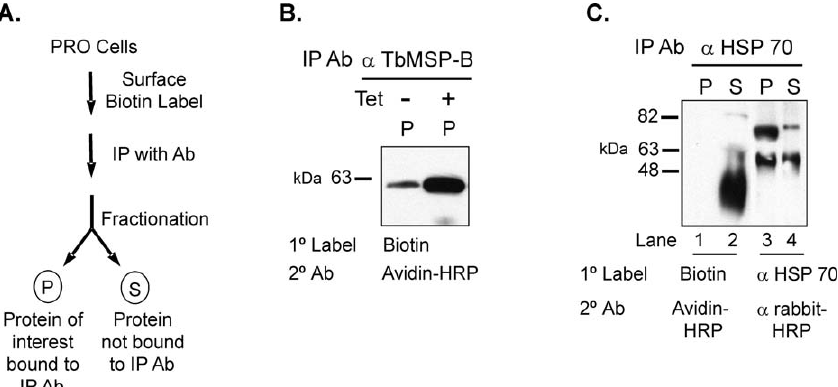
Figure 2. TbMSP-B Can Be Surface Biotinylated (A) Summary of the biotinylation and immunoprecipitation protocol used to detect proteins on the surface of PRO cells that are labeled with biotin. PRO cells were surface biotin-labeled with EZ-Link Sulfo-NHS-Biotin (Pierce), followed by cell lysis and immunoprecipitation (IP) of cell extracts with antiserum directed against TbMSP-B or HSP-70. (B) PRO cells bearing integrated pLEW82/TbMSP-B were not induced ( (cid:2) Tet) or induced ( þ Tet) with 1 l g tetracycline/ml for 24 h prior to surface biotinylation and immunoprecipitation with affinity-purified MSP-B antiserum ( a TbMSP-B). Proteins in the pellet fraction (P) were separated on an SDS- PAGE gel, and surface biotin-labeled proteins were visualized using an avidin-HRP secondary antibody. (C) PRO cells were surface biotinylated and rabbit HSP-70 antiserum ( a HSP-70) was used to immunoprecipitate HSP-70 protein from the cell extracts. In lanes 1 and 2, the pellet (P) and supernatant (S) fractions are shown in which biotin was the primary label, followed by visualization of the biotin-labeled proteins with secondary avidin-HRP. The major band in lane 2 is biotin-labeled procyclin. Lanes 3 and 4 show a western blot in which the P and S fractions were incubated with rabbit HSP-70 antiserum followed by an anti-rabbit-HRP secondary antibody.